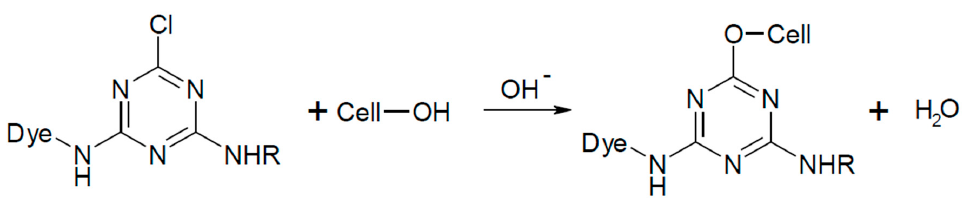
Figure 4. Reaction of a reactive dye with cellulose. Reprinted by permission from the Springer Nature, Fibers and Polymers, The e ff ect of biodegradable organic acids on the improvement of cotton ink-jet printing and antibacterial activity, Soleimani-Gorgani, A., Karami, Z. Copyright (2017) [25]. Dyes containing a vinylsulfonyl moiety as a reactive system or a 2-sulfate ethylsulfonyl moiety, which is a precursor of the vinylsulfonyl moiety, react with cellulose fiber according to the reaction mechanism of nucleophilic attachment to an unsaturated bond [13,18,20]. The example of such a reaction is shown in Figure 5.